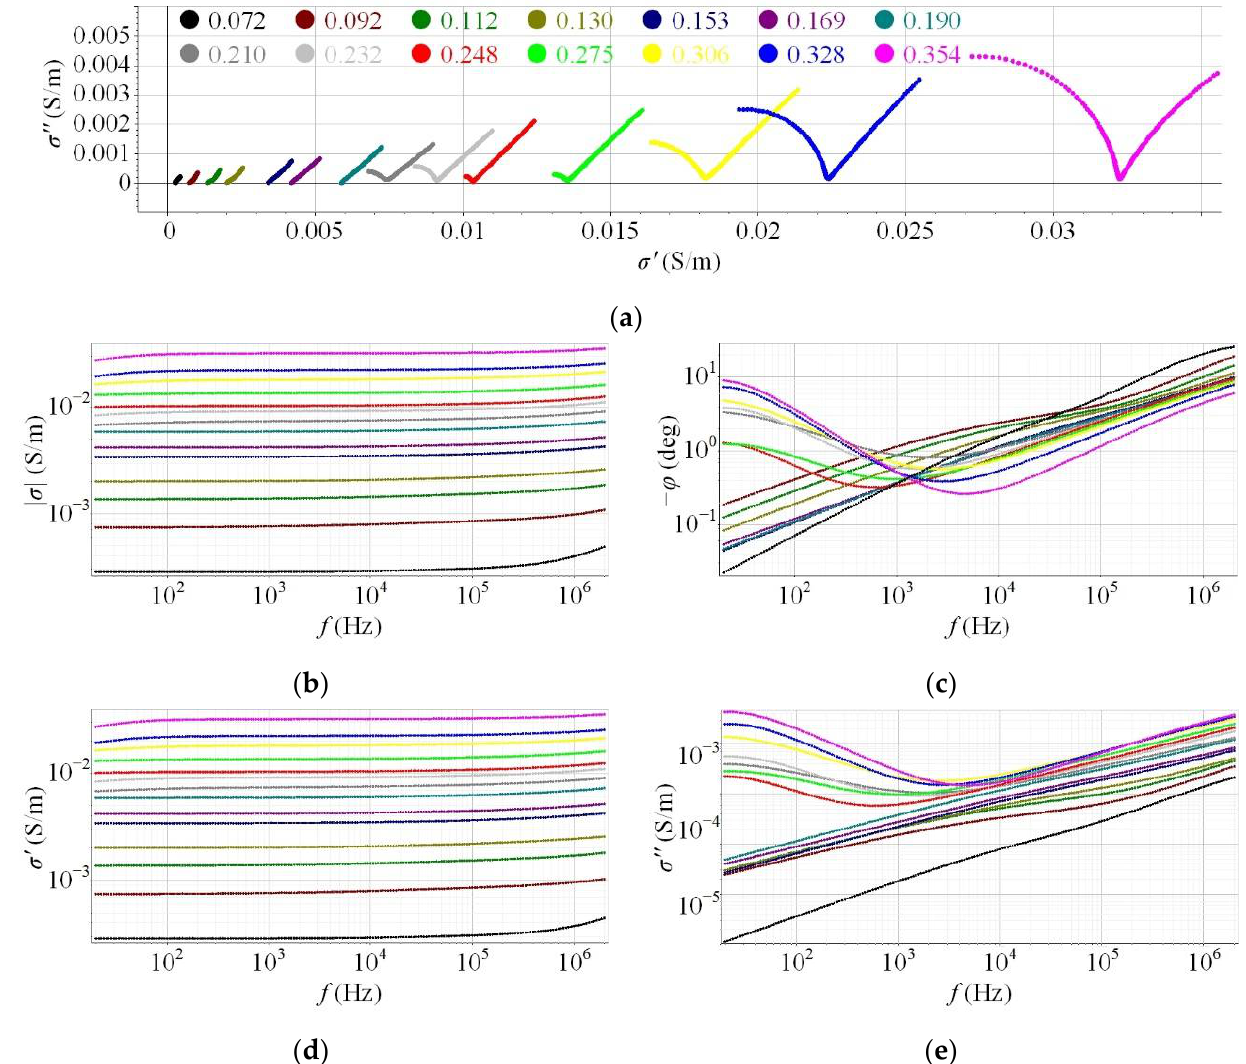
Figure 5. Impact of changes in volumetric water content on complex conductivity spectra of substrate. ( a ) Nyquist plots; ( b ) magnitude spectra; ( c ) phase spectra; ( d ) in-phase conductivity spectra; ( e ) quadrature conductivity spectra. For the spectra marked by different colors, the variable volumetric water contents are provided in ( a ), while the related dry densities (Table 1) are considered to be nearly equal. The frequency range is from 20 Hz to 2 MHz.